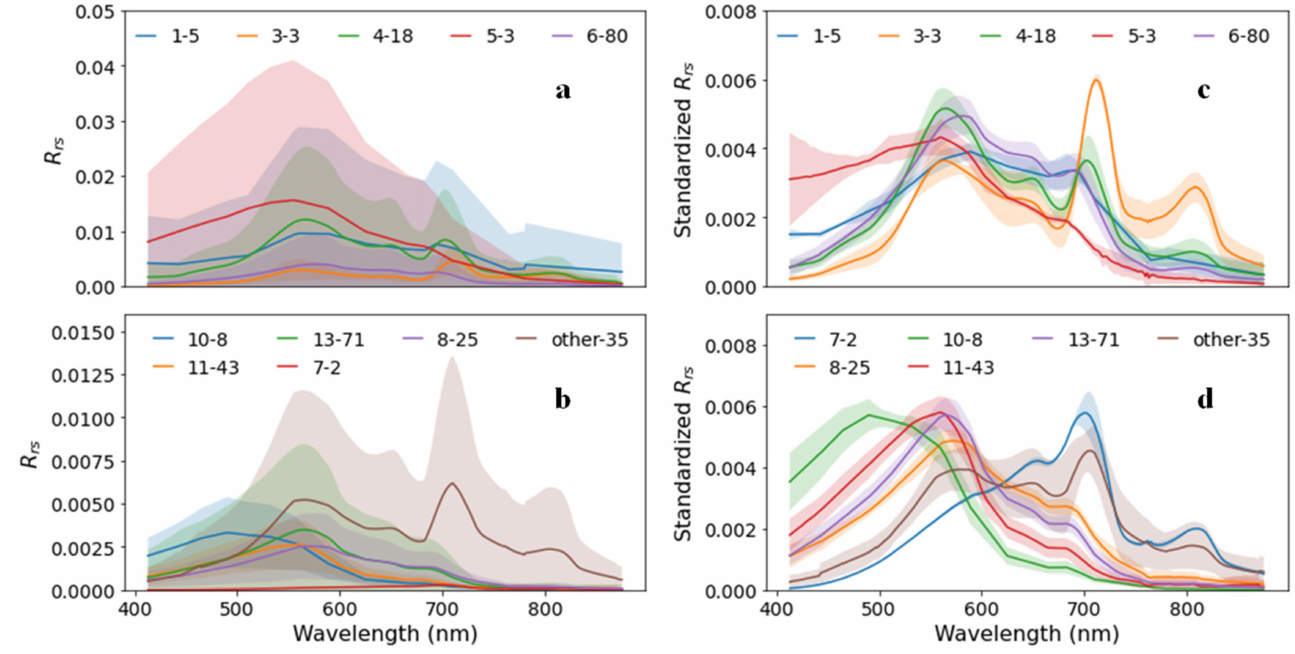
Figure 3. Rrs spectra used in this paper, collected in LakePulse fieldwork and their classifications. ( a , b ) Mean and standard deviation of the Rrs spectra for each inland water type ( c , d ) Mean and standard deviation of the standardized Rrs spectra for each inland water type. The labels of the legend represent the water type index [63] and the number of spectra belonging to each type connected by